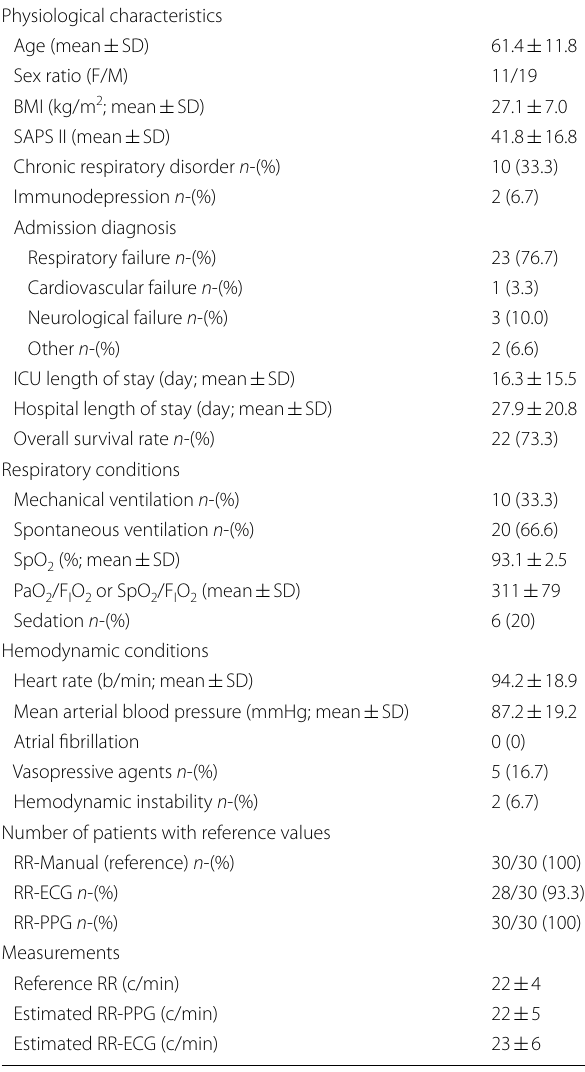
Table 3 Physiological characteristics of the patients— prospective phase ( N 30 =